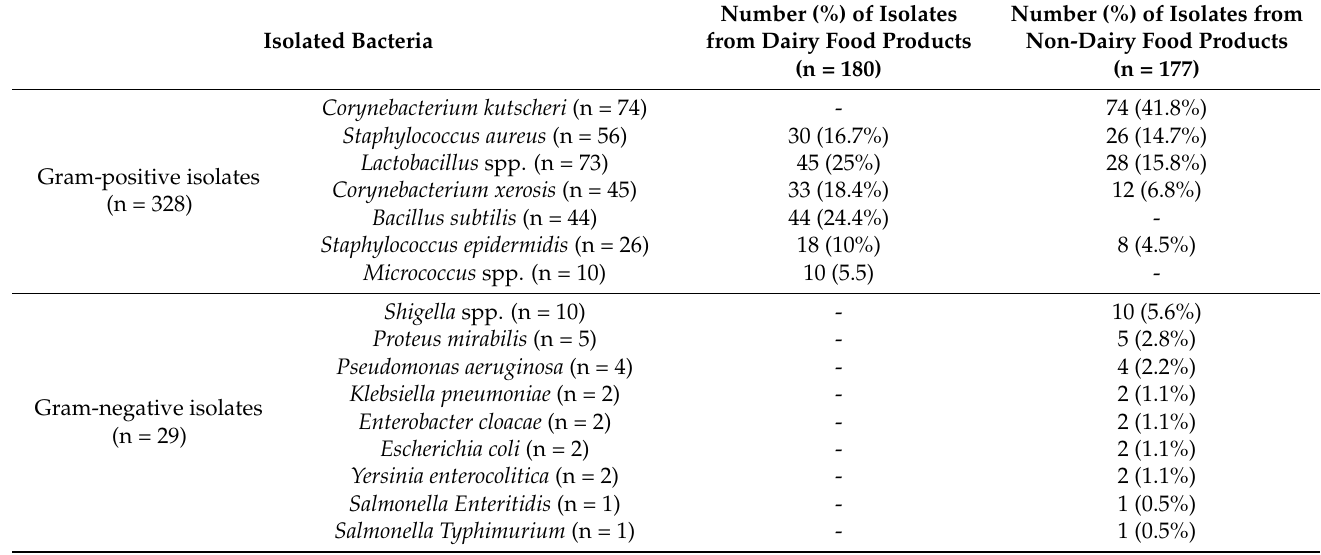
Table 2. Distribution of Gram-positive and Gram-negative bacterial isolates (n = 357) in dairy and non-dairy food